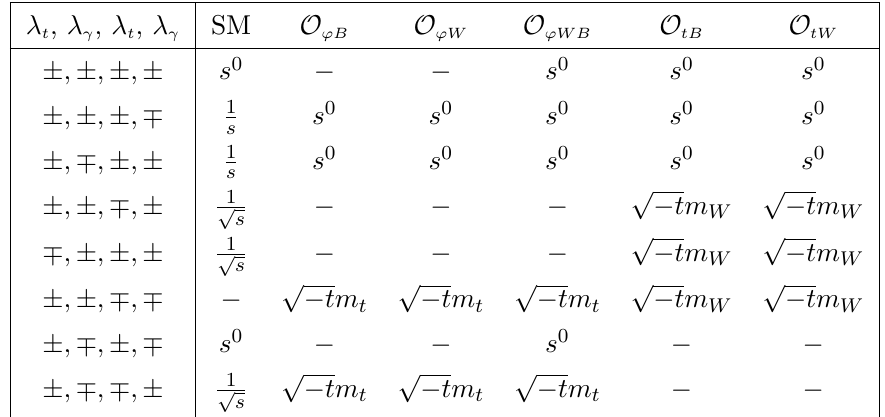
Table 16. Helicity amplitudes in the high-energy limit ( s Overall multiplicative factors are dropped and only the schematic energy dependence is retained for the SM contribution. Helicity entries marked by ‘ section 5.1.4 for a discussion of the